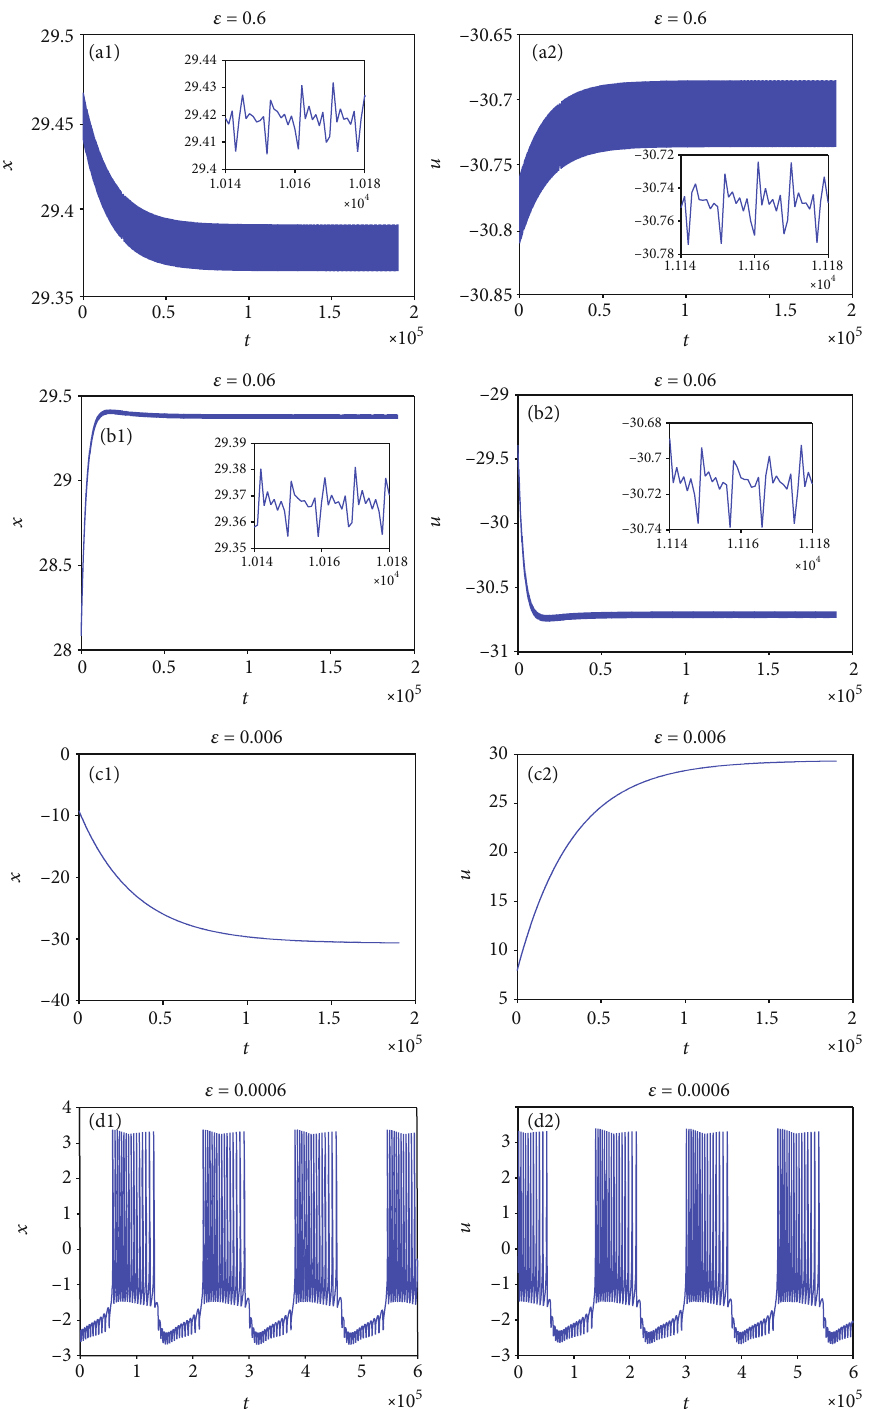
Figure 18: Multiple fi ring patterns of model (8) with small-scale ε changing when k = 0 : 5 and I